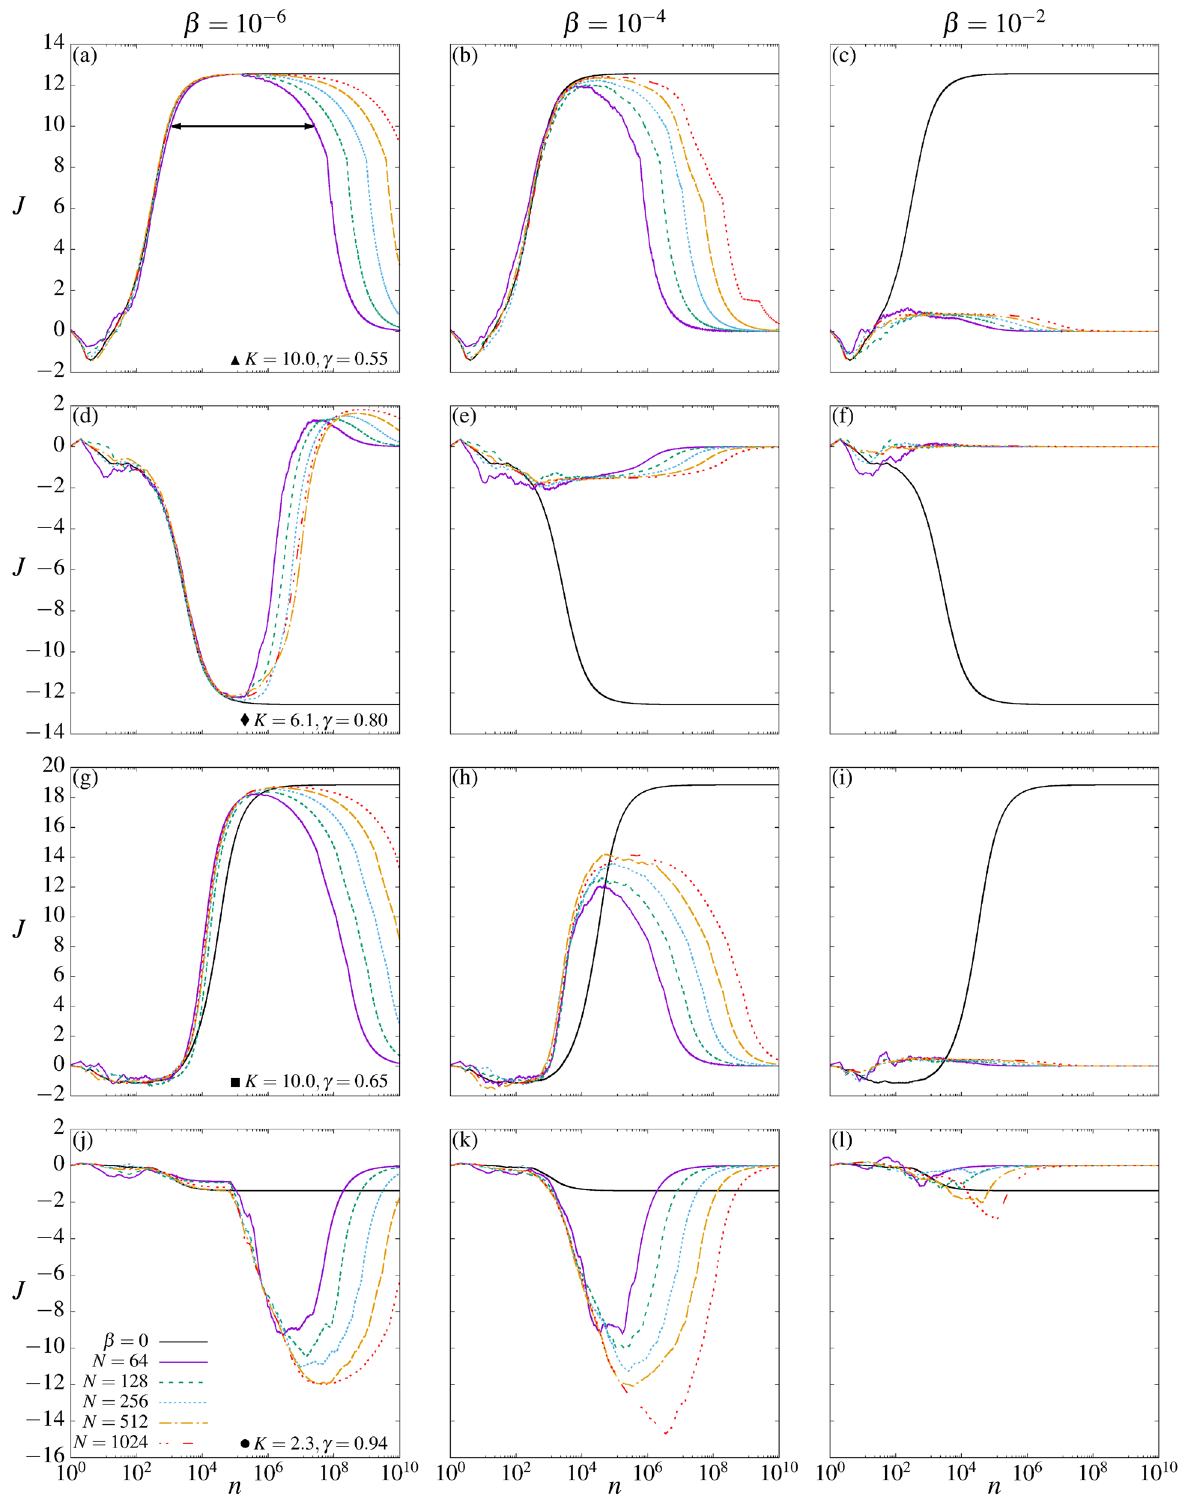
Figure 2. Curves for the RC J as function of iteration time n and for a distinct number N of coupled systems. The pair of parameters are K = 10.0, γ = 0.55 for ( a – c ), K = 6.1, γ = 0.80 for ( d – f ), K = 10.0, γ = 0.65 for ( g – i ), and K = 2.3, γ = 0.94 for ( j – l ). The black continuous curves are the J for the corresponding parameters in the uncoupled cases, for 1024 initial condition. The arrow in ( a ) exemplifies how the lifetime τ is determined